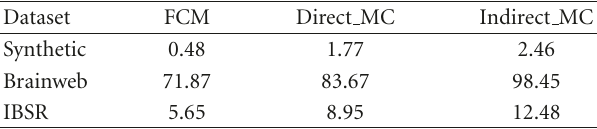
Table 1: Execution time (seconds/image for synthetic and sec- onds/volume for MR images) of proposed algorithms and FCM. Dataset